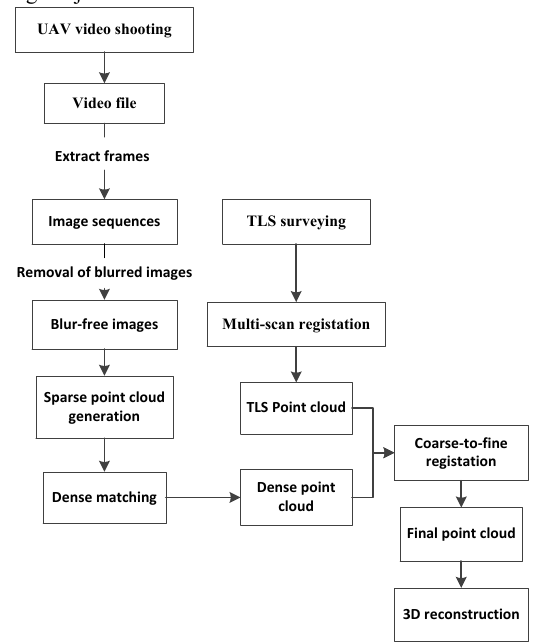
Figure 2 Framework of the proposed